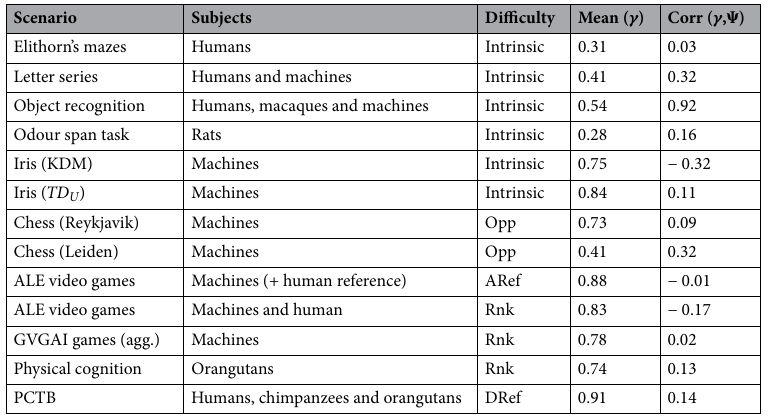
Table 2. Summary of the scenarios and subjects seen in the paper. Difficulty modalities as per Table 1. The last two columns show the mean normalised generality and its correlation with